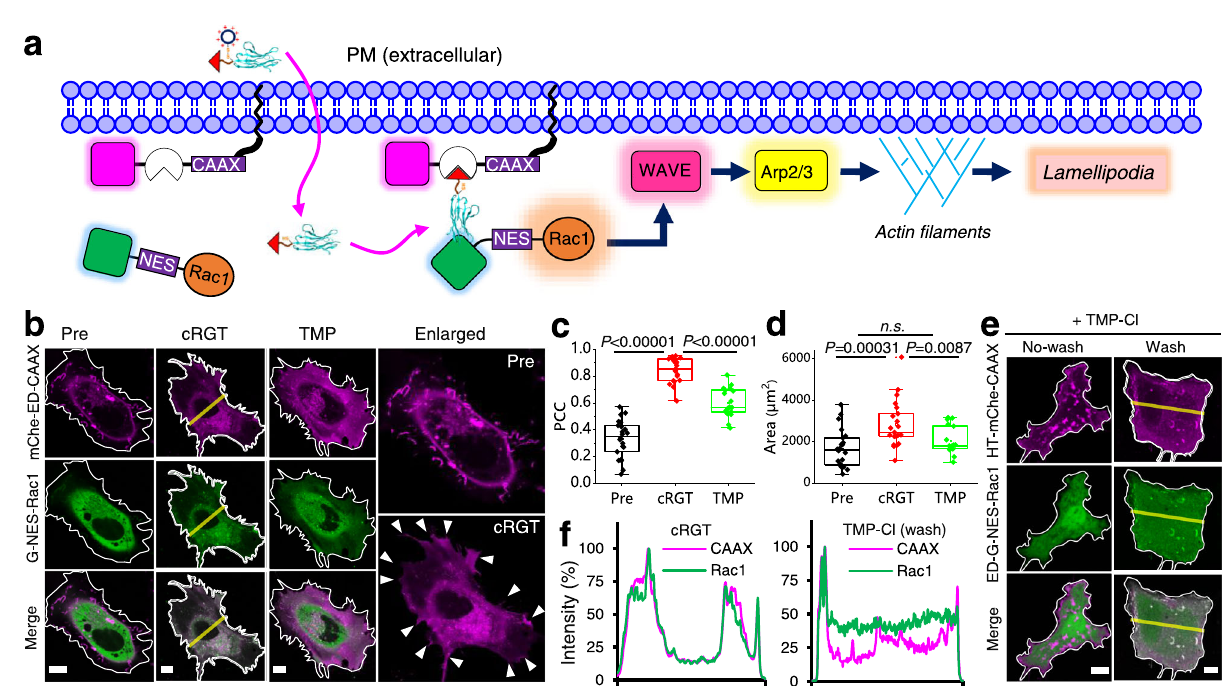
Fig. 3 | cRGT brings the signaling protein Rac1 to the proximity ofinner PMto initializethesignaling cascadeoflamellipodiaformation. a Anon-PM targeting and constitutively active EGFP-NES-Rac1Q61L Δ CAAX (i.e. G-NES-Rac1) mutant with the truncation of its PM-targeting C-terminal CAAX-box was engineered and co- expressed with mCherry-eDHFR-CAAX in live HeLa cells; treatment of HeLa cells with cRGT will target Rac1 mutant to the functional PM location and initialize lamellipodiasignalingpathway.WAVEWASp-familyverprolin-homologousprotein, Arp2/3 actin-related proteins-2/3. b Representative live HeLa cells coexpression of G-NES-Rac1(green,cytosolic)andmCherry-ED-CAAX(red,PM)beforeaddingcRGT (Pre), after treatment with cRGT (24 μ M, 1.5h), and after adding TMP (10 μ M, 10min); NES: nucleus exporting signal, LQNKLEELDL, which reduces Rac1 ’ s